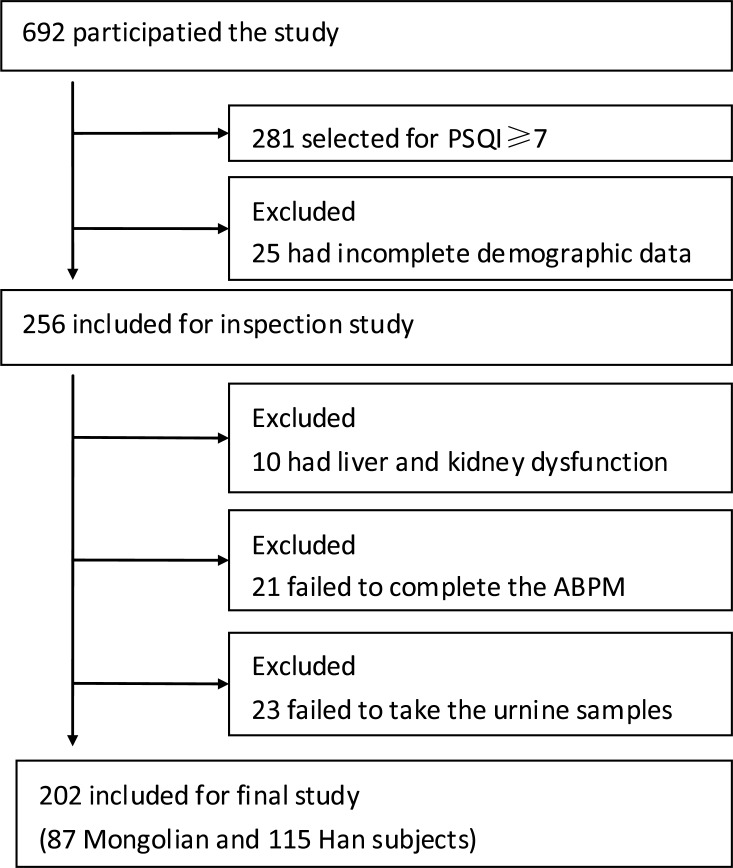
Study flow chart of subjects.ABPM, ambulatory blood pressure monitoring.